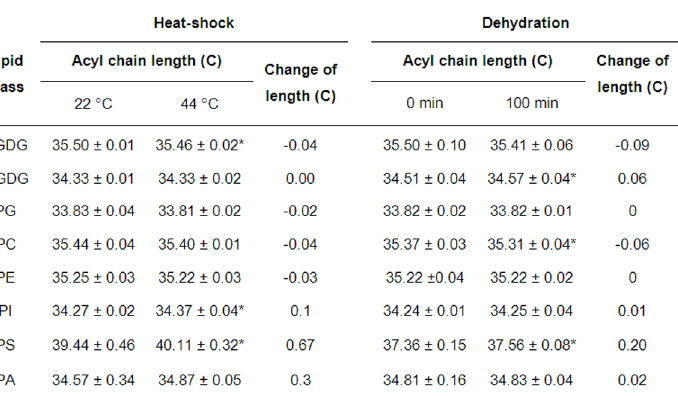
Figure 5. Acyl chains of PS lengthen under stresses in Arabidopsis . (Left panel) The acyl chain length of membrane glycerolipids under heat shock at 44 u C for 2 h. ( Right panel ) The acyl chain length of membrane glycerolipids under dehydration for 100 min. Values are means 6 s.d. ( n =5). An asterisk indicates that the value is different from that of the control ( p , 0.05).